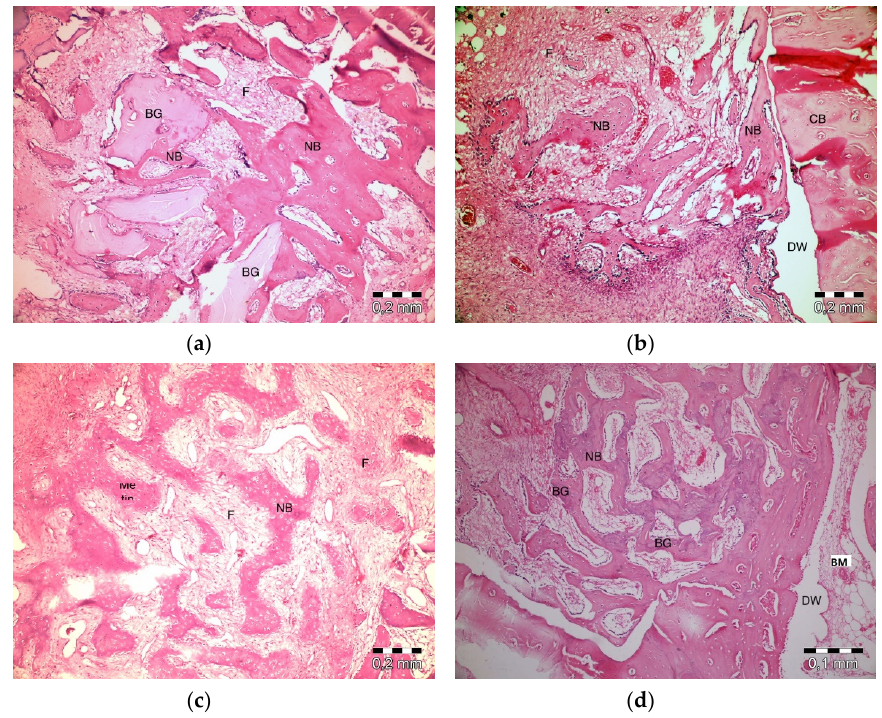
Figure 4. Histologic findings on the 20th day. ( a ): PRF + ABB; ( b ): PRF; ( c ): Empty Defect; ( d ): ABB + CM. N: New bone area; F: Fibrosis; BG: Bone graft; DW: Defect wall; CB: Compact bone; BM: Bone marrow.